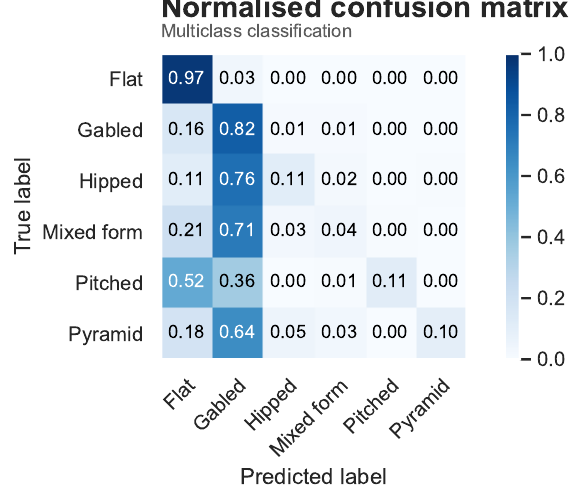
Figure 6. Performance of the multiclass classification.